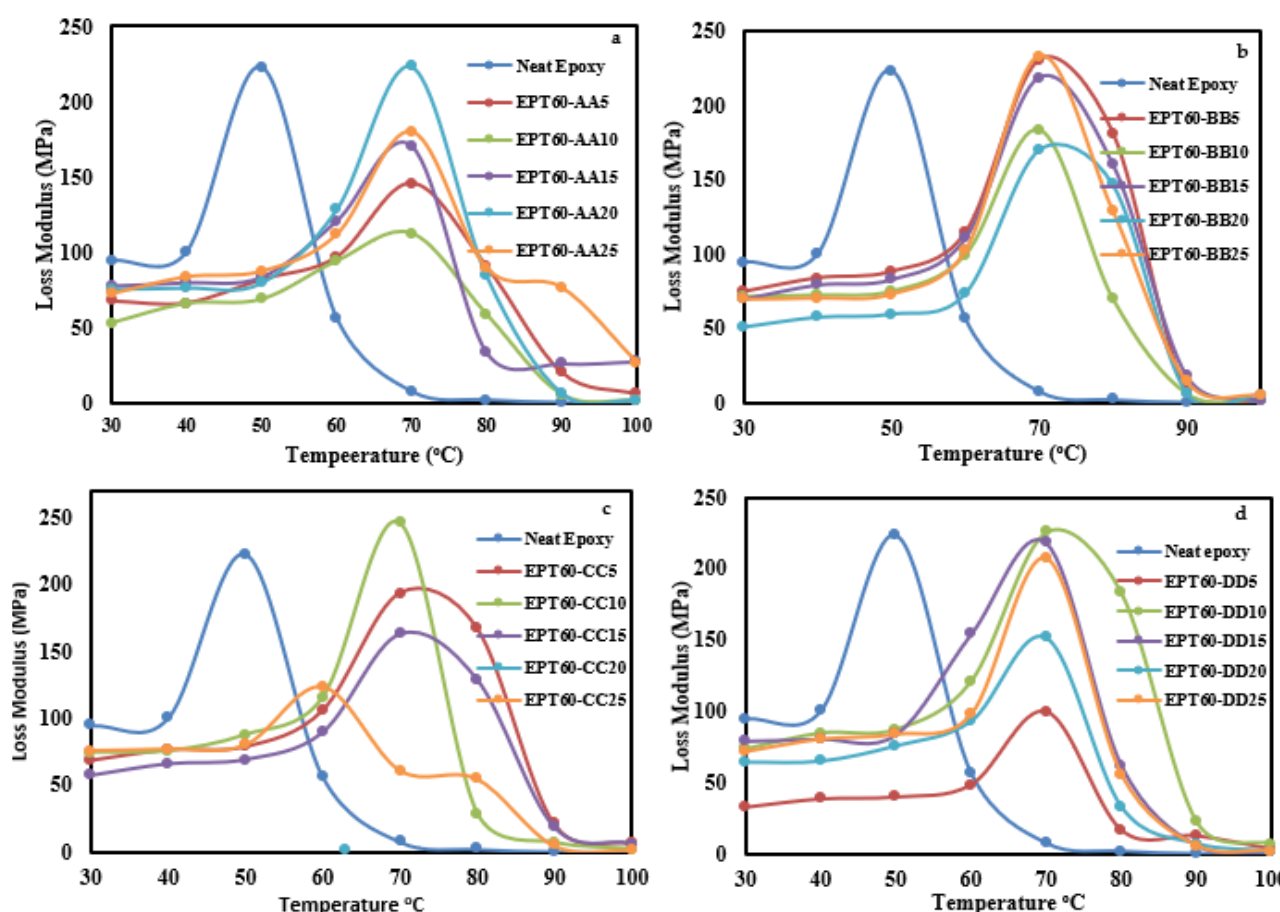
Figure 10. Loss modulus of SFC-homogenous HGM at ( a ) EPT60-AA, ( b ) EPT60-BB, ( c ) EPT60-CC, and ( d ) EPT60-DD Showing all the volume fraction variations compared with the neat